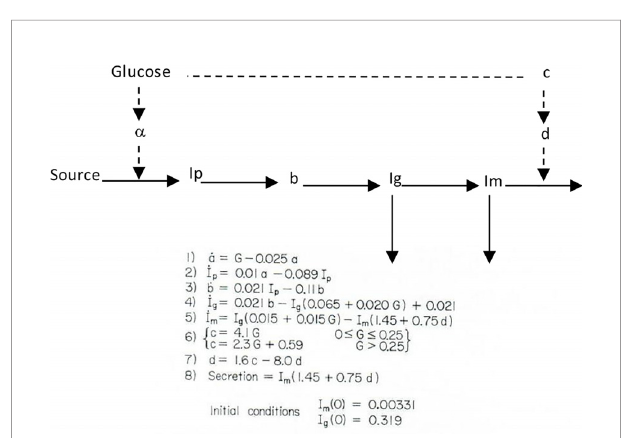
FIGURE 2 | Biphasic insulin release from